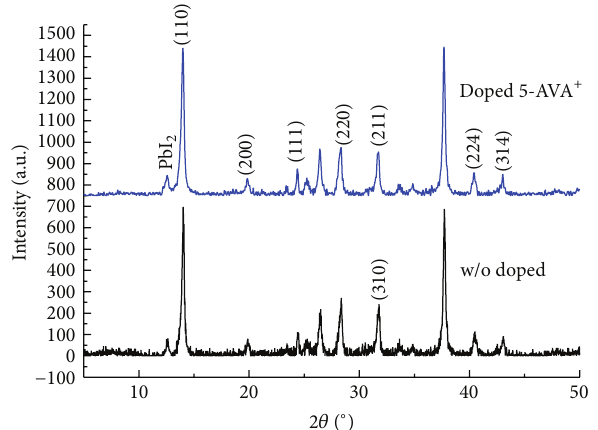
Figure 7: XRD patterns corresponding to perovskite films fabricated with/without doping 5-AVA +